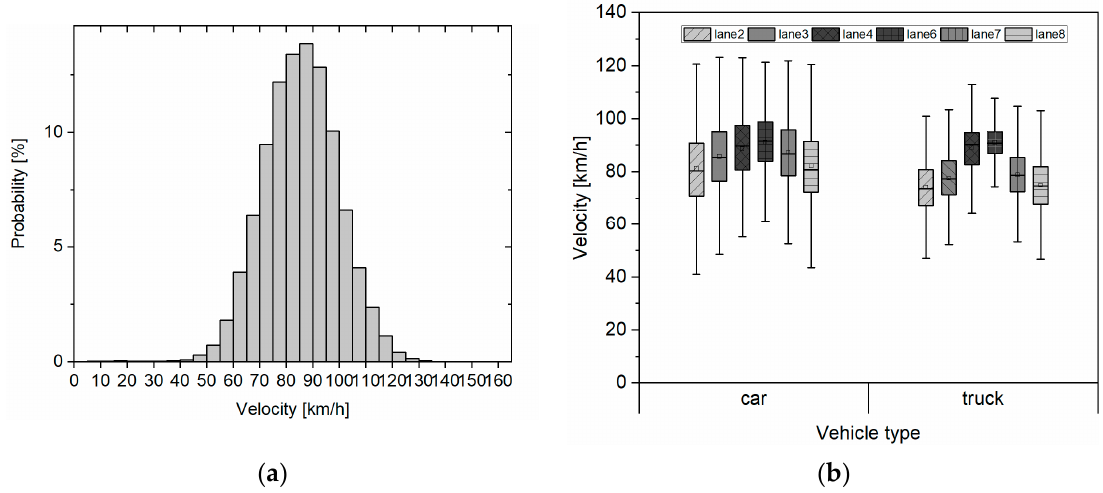
Figure 9. ( a ) Probability distribution of velocity; ( b ) Velocity for car and truck in different lanes.